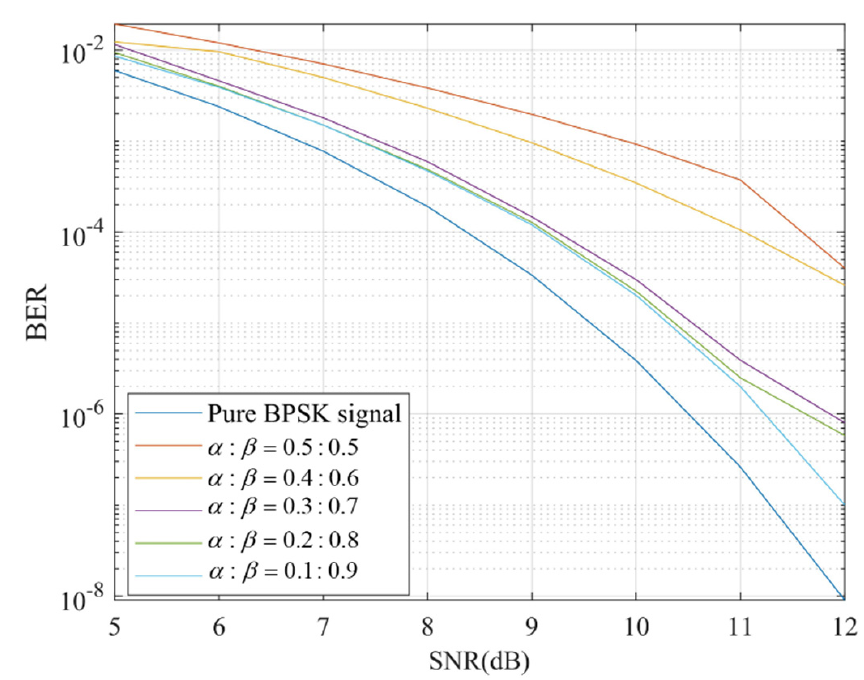
Figure 11. The data transmission error rate of a composite signal and pure signal.